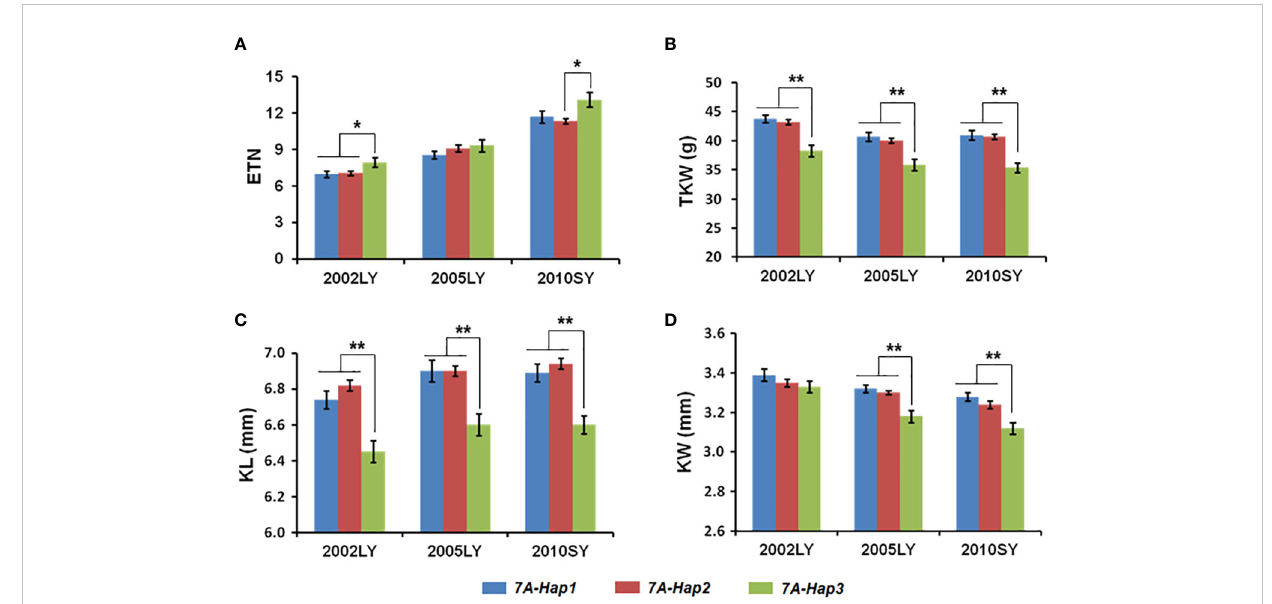
FIGURE 5 Association analysis of TaSPL14-7A haplotypes with tiller number and kernel traits in modern cultivars in three different environments. (A) Effective tiller number (ETN); (B) Thousand kernel weight (TKW); (C) Kernel length (KL); (D) Kernel width (KW) of modern cultivars with different TaSPL14-7A haplotypes. The x-axis represents different environments: Luoyang, 2002 (2002LY); Luoyang, 2005 (2005LY); Shunyi, 2010 (2010SY). The values are presented as mean ± SE. ** P <0.01; * P <0.05 (ANOVA).